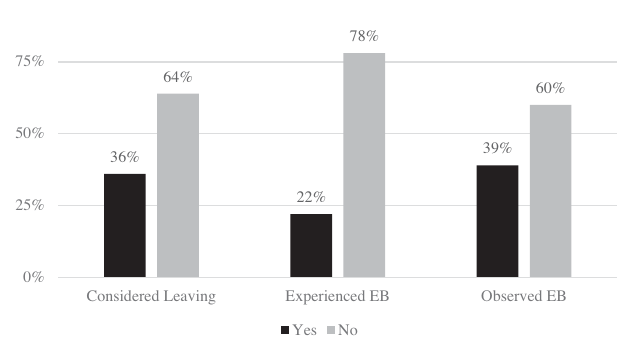
FIG. 1. Consideration to leave, experience, and observation of exclusionary